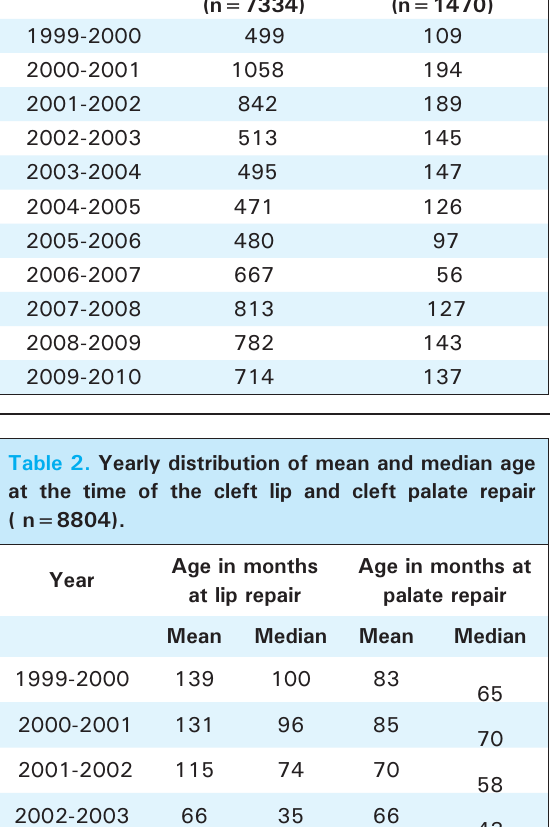
Table 1. Yearly distribution of cleft lip and cleft palate repairs (n=8804).